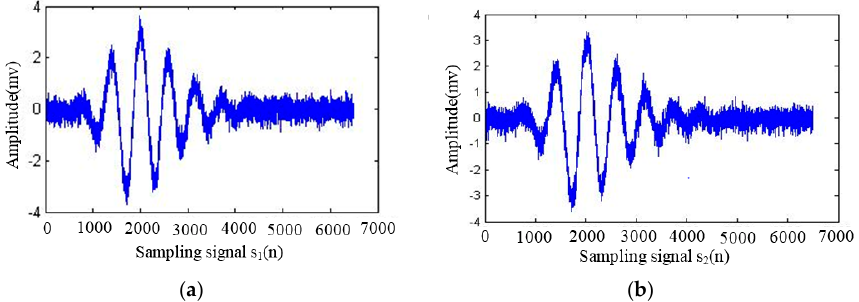
Figure 6. Time-domain diagram of the sampling signal [66]. ( a ) Under 34 MPa tensile stress; ( b ) under 230 MPa tensile stress. “Reproduced with permission from published by © Zhongguo Zhendong Gongcheng Xuehui.” (2013).